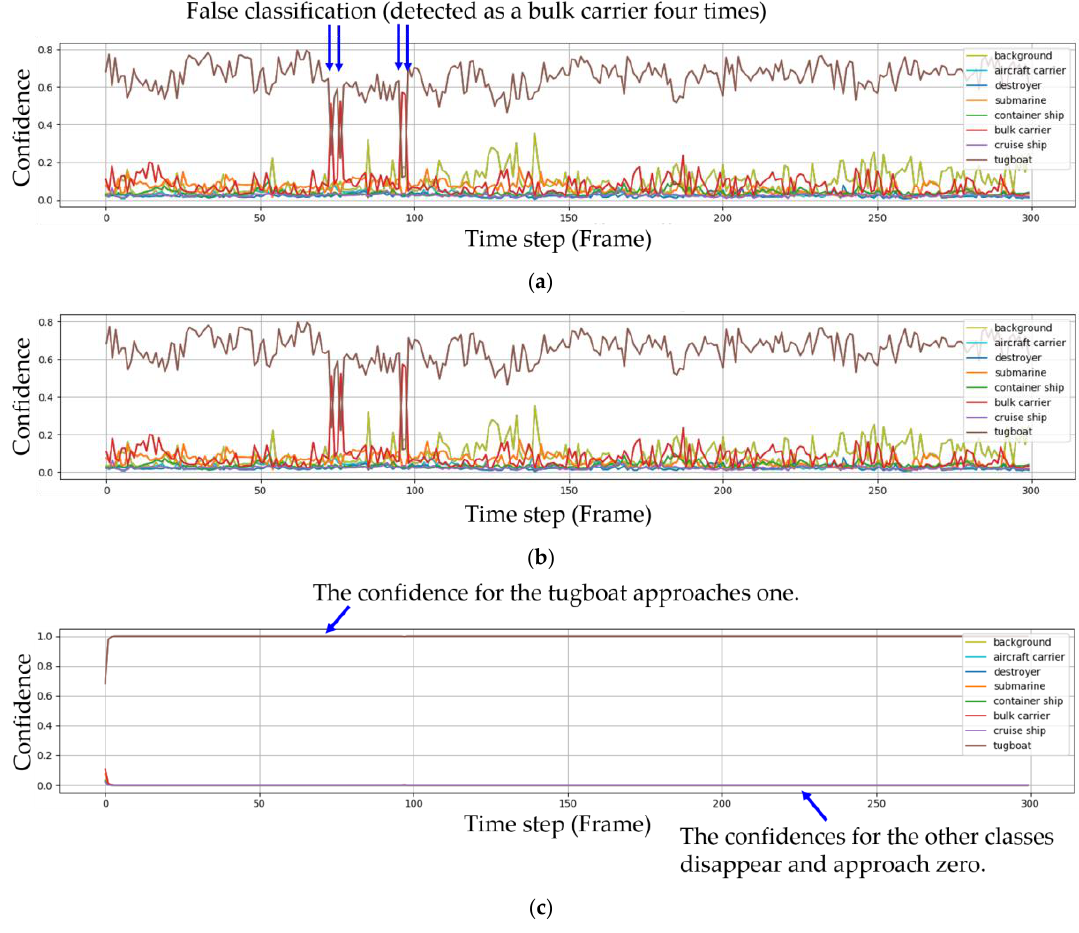
Figure 7. The change of confidences in the image sequence without environmental factors. ( a ) Faster R-CNN, ( b ) Faster R-CNN and IoU tracking, and ( c ) Faster R-CNN, IoU tracking, and Bayesian fusion.